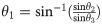
Panel A: A geographical slant with a slope of 30°. Panel B: Given the slope of hill and the desired ascension gradient, one can calculate the angle of deviation of the path from the straight path (θ1) via the equation: θ1=sin−1(sinθ2sinθ3), where θ2 is desired path gradient and θ3 is the slope of the hill.